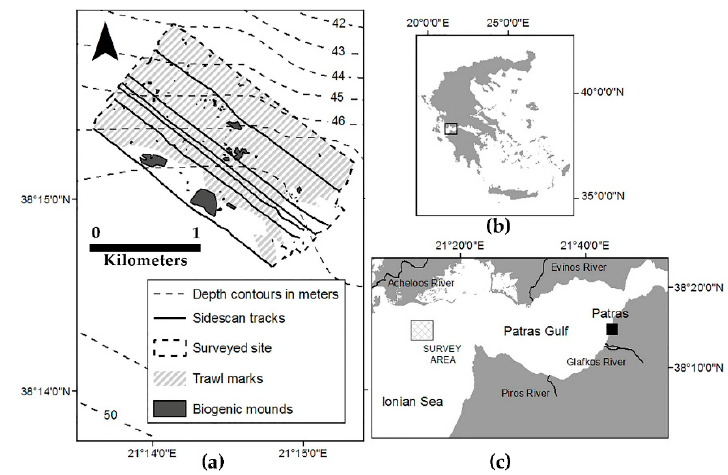
Figure 1. ( a ) The study area, ( b ) The location of Gulf of Patras, ( c ) Gulf of Patras (revised from Patsourakis et al. [24]).